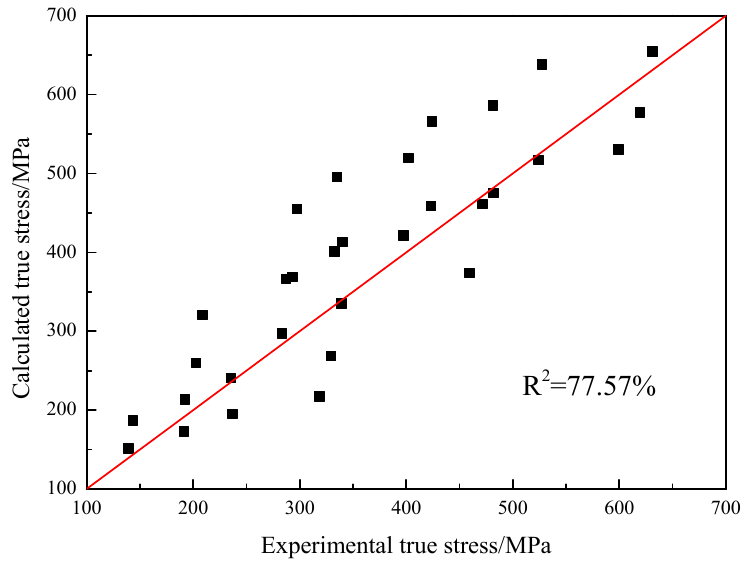
Figure 9. The comparison between the true stress calculated by the JC model and the experimental results.